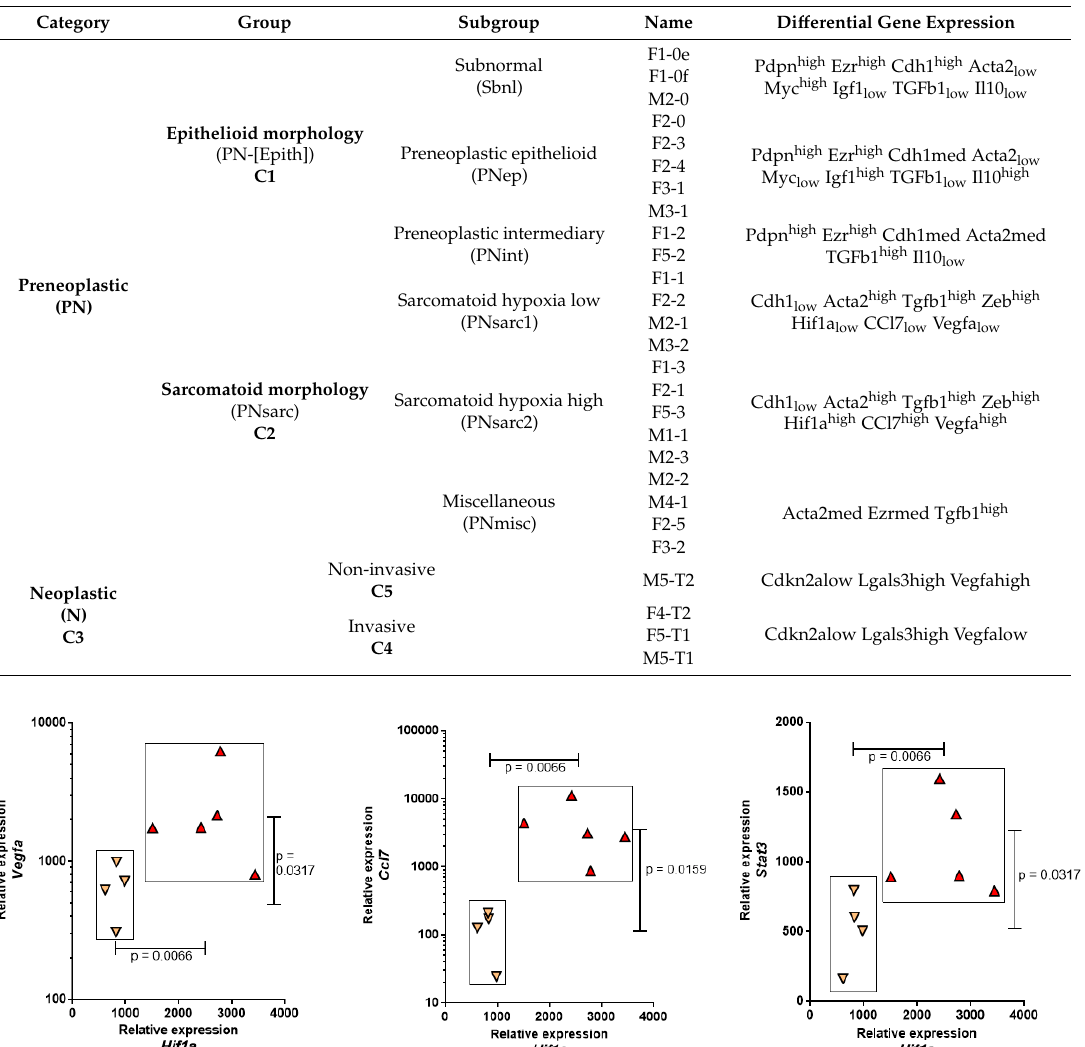
Table 1. Classification of the biocollection of rat mesothelial cell lines. Roulois et al. [18] showed photographs of each cell line at confluence and their growth characteristics (Supplementary Figure S2 and Table S1, respectively).